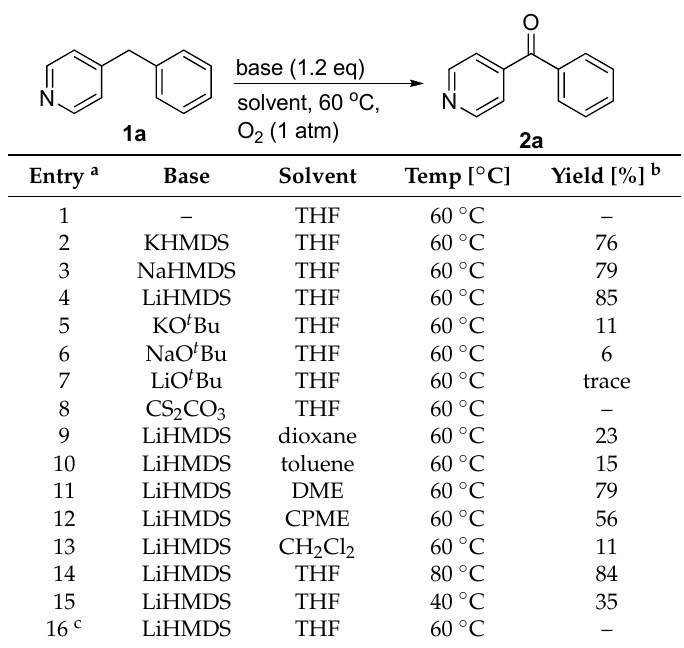
Table 1. Optimization of the reaction conditions.